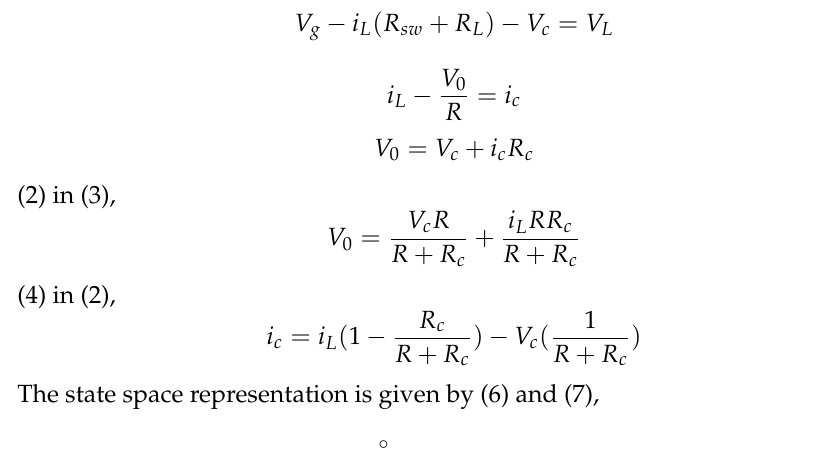
Figure 3. Schematic of the converter.